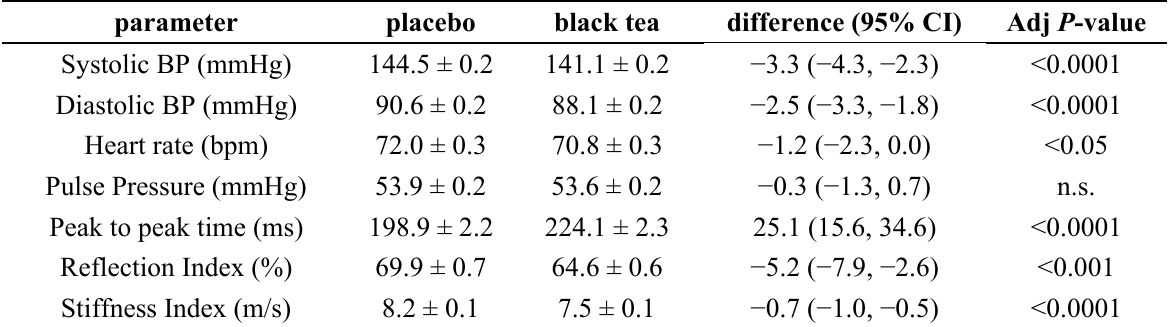
Table 3. Effect of black tea on haemodynamic parameters after one week intervention measured in the fasted state.